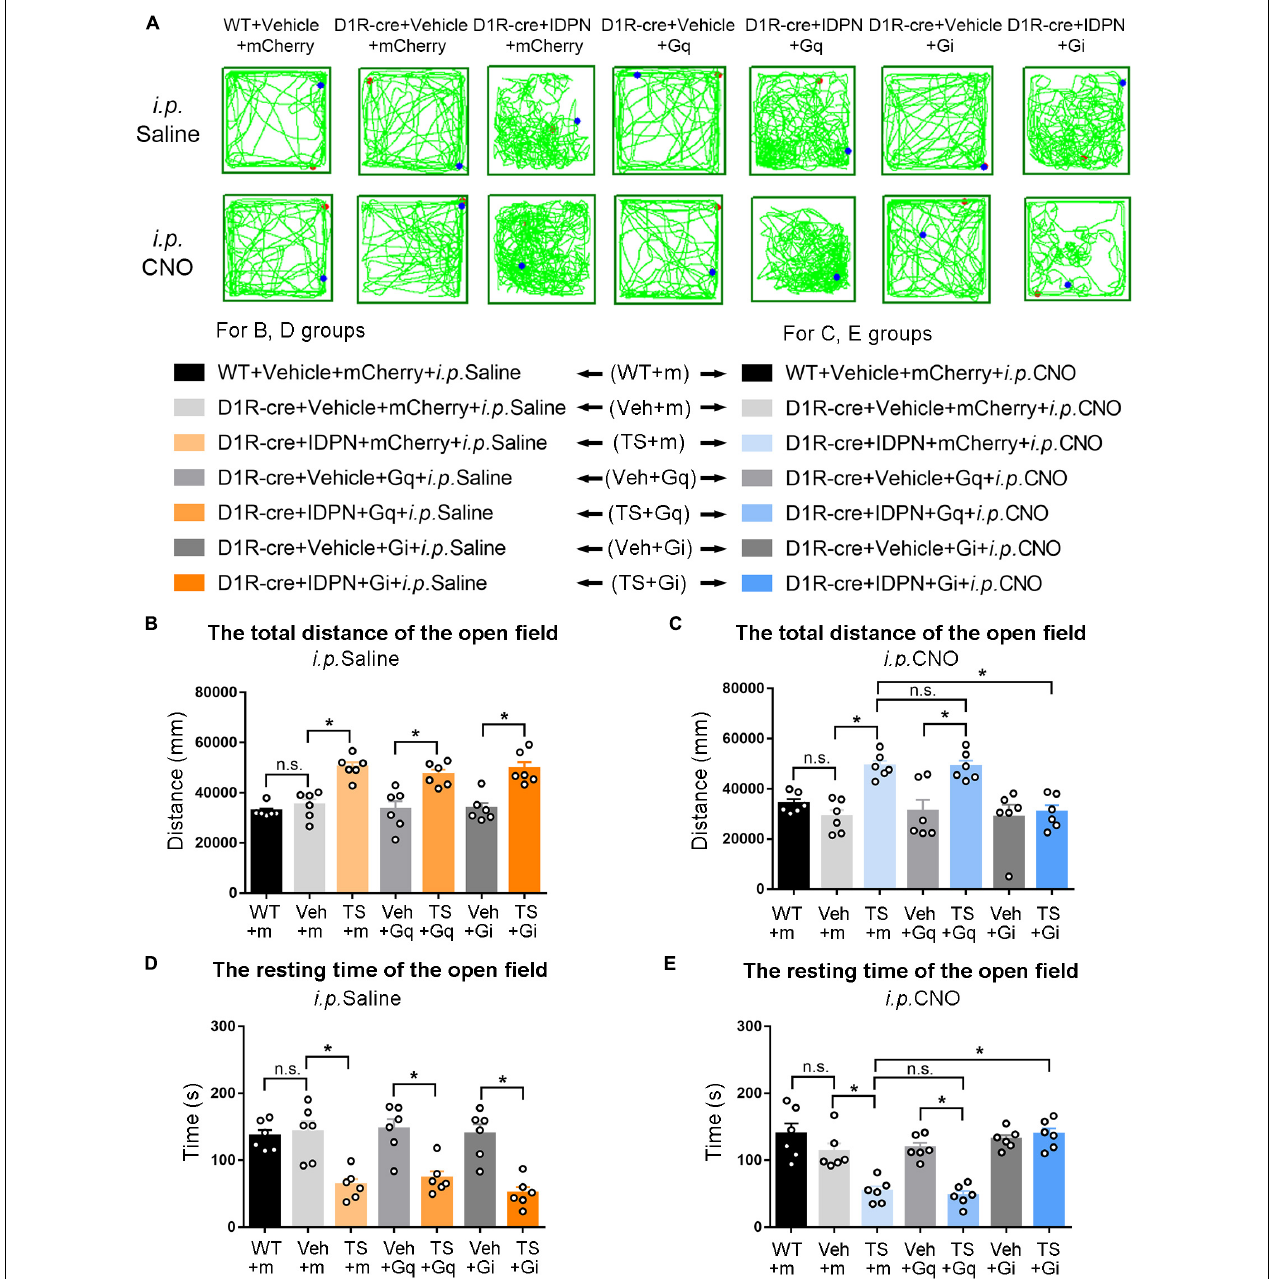
FIGURE 3 | Effects of activation or inhibition of D1R-containing neurons in the SNpc on total distance and resting time in the open-field test in mice. (A) Evaluations of the trajectory in the open-field test in mice 30 min after the injection of saline (i.p. Saline) or CNO (i.p. CNO) in the WT + Vehicle + mCherry + i.p. Saline group (WT + m), D1R-cre + Vehicle + mCherry + i.p. Saline group (Veh + m), D1R-cre + IDPN + mCherry + i.p. Saline group (TS + m), D1R-cre + Vehicle + Gq + i.p. Saline group (Veh + Gq), D1R-cre + IDPN + Gq + i.p. Saline group (TS + Gq), D1R-cre + Vehicle + Gi + i.p. Saline group (Veh + Gi), D1R-cre + IDPN + Gi + i.p. Saline group (TS + Gi), WT + Vehicle + mCherry + i.p. CNO group (WT + m), D1R-cre + Vehicle + mCherry + i.p. CNO group (Veh + m), D1R-cre + IDPN + mCherry + i.p. CNO group (TS + m), D1R-cre + Vehicle + Gq + i.p. CNO group (Veh + Gq), D1R-cre + IDPN + Gq + i.p. CNO group (TS + Gq), D1R-cre + Vehicle + Gi + i.p. CNO group (Veh + Gi), D1R-cre + IDPN + Gi + i.p. CNO group (TS + Gi) on day 23. (B) Total distance in the open-field test within 10 min in mice of each group 30 min after the injection of saline (i.p. Saline) on day 23. (C) Total distance in the open-field test within 10 min in mice of each group 30 min after the injection of CNO (i.p. CNO) on day 23. (D) Resting time in the open-field test within 10 min in mice of each group 30 min after the injection of saline (i.p. Saline) on day 23. (E) Resting time in the open-field test within 10 min in mice of each group 30 min after the injection of CNO (i.p. CNO) on day 23. Data are expressed as mean ± SEM ( n = 6 mice in each group), and the black line segment indicates the differences between groups, * represents P < 0.05 between marked groups, and n.s. represents P > 0.05 between marked groups.